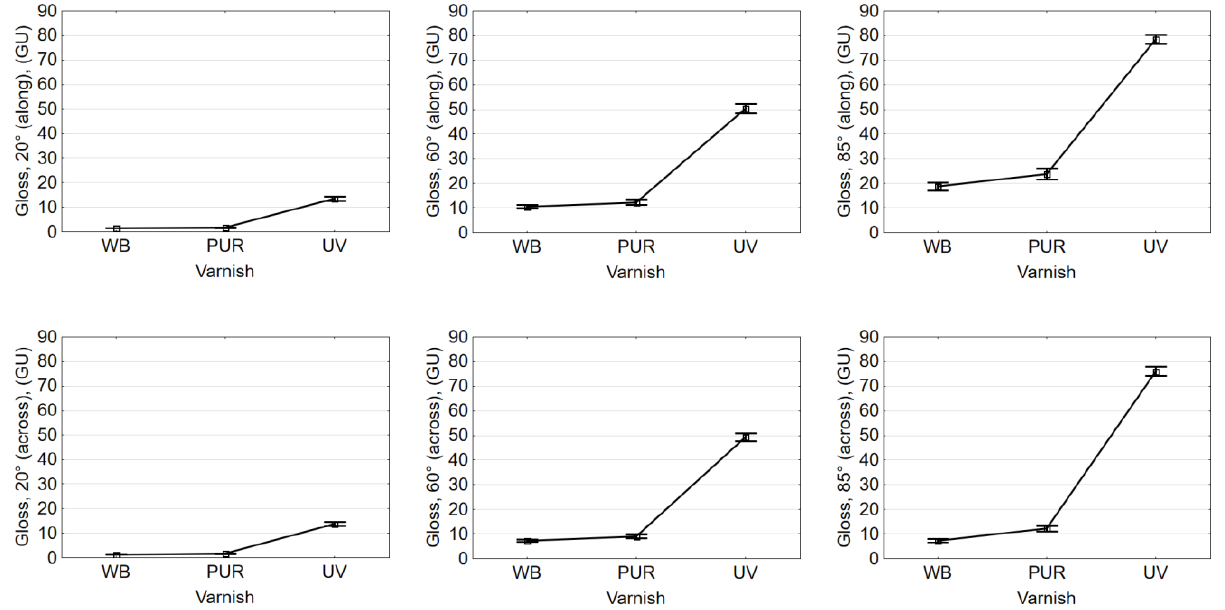
Figure 4. Main effects plot for mean gloss for different varnishes for each measurement angle.